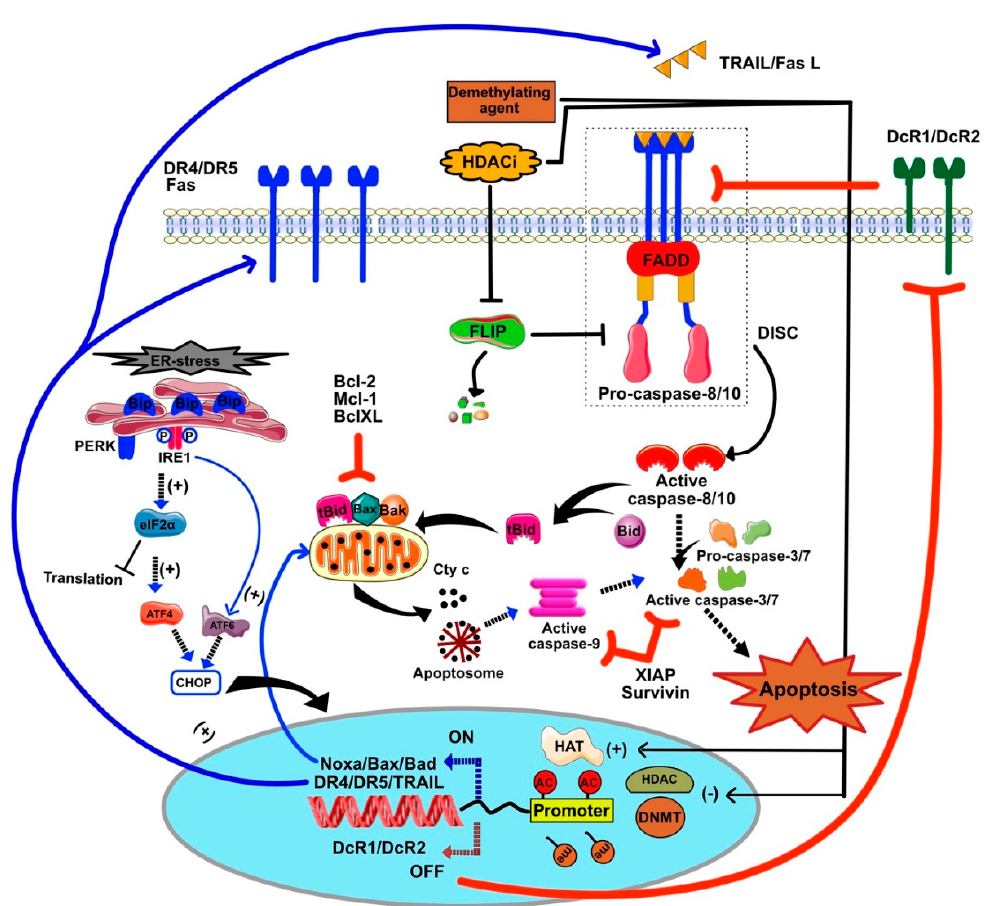
Figure 9. Schematic diagram summarizing the different cell death signaling pathways-induced by epigenetic modification of chromatin following treatment with HDAC inhibitors and demethylating agents.